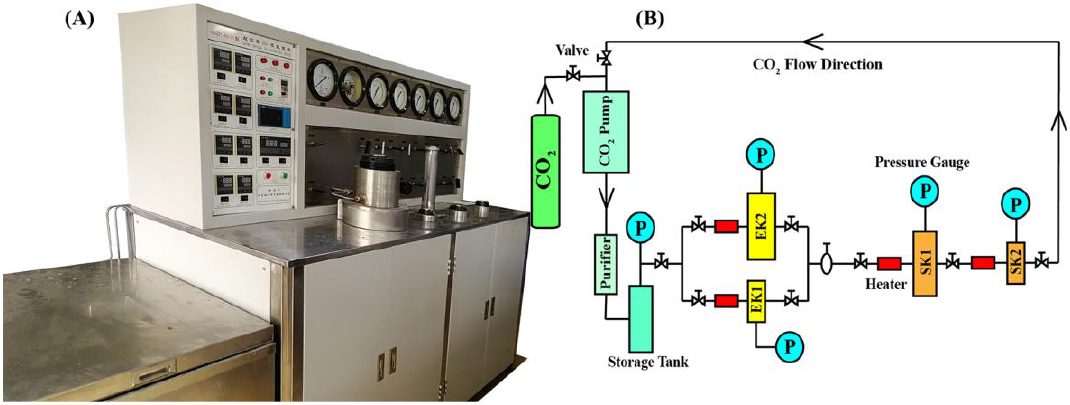
Figure 5. The CO 2 supercritical fluid extraction (CO 2 -SFE) equipment. ( A ) The HA221-40-11 CO 2 -SFE device used in this work. ( B ) The diagrammatic sketch of working principle of CO 2 -SFE equipment. EK1 and EK2 are two parallel extraction kettles. SK1 and SK2 are two separation kettles in series.